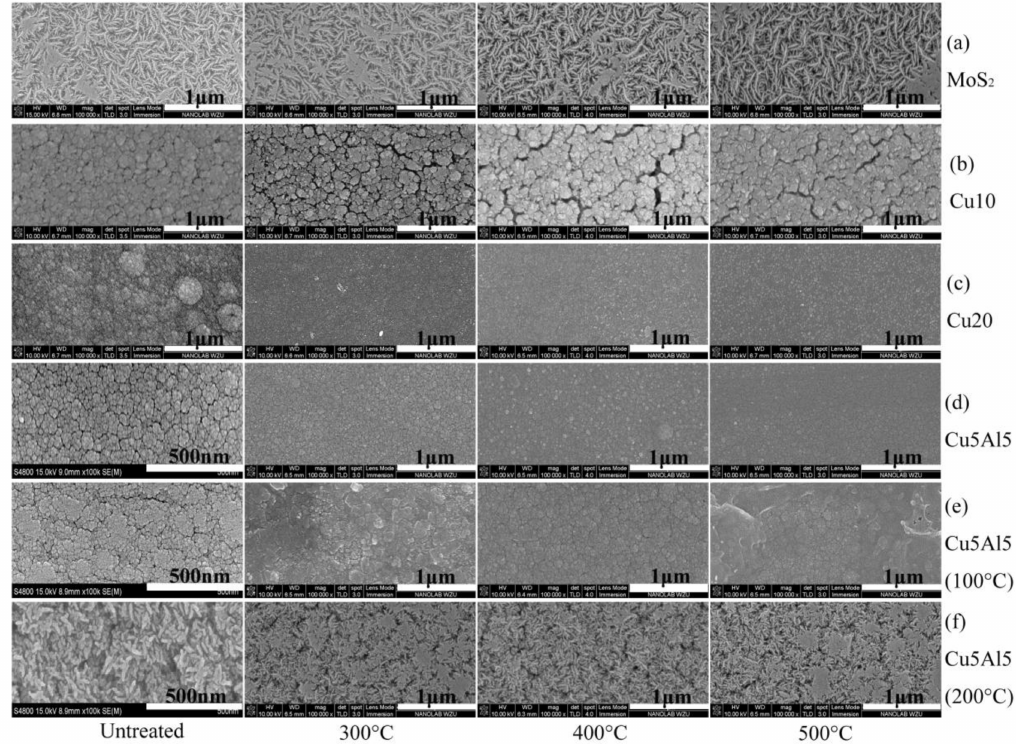
Figure 2. SEM morphologies of composite coatings at various heat treatment